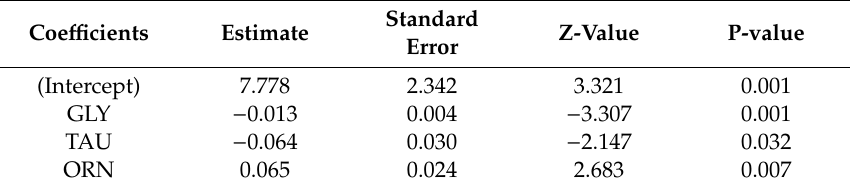
Table 2. The optimal multivariate regression model using serum concentration of glycine, taurine, and ornithine.